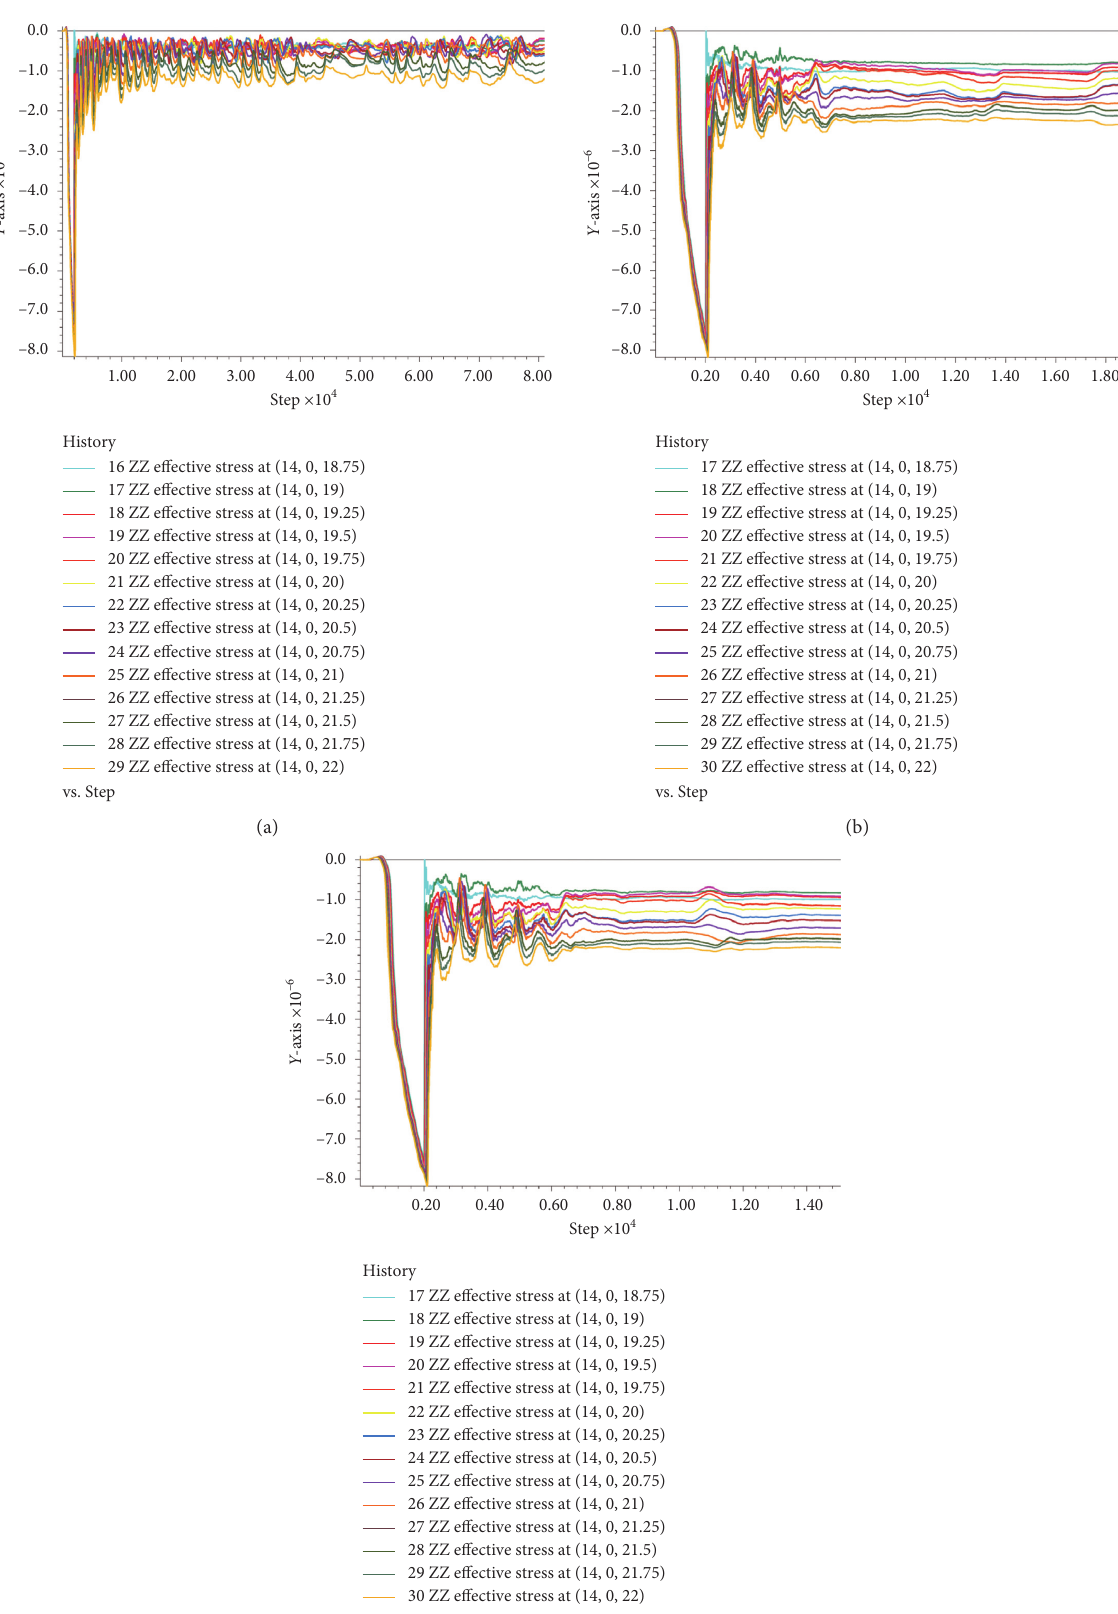
Figure 8: Variation of maximum effective stress of roadway roof. (a) No support state. (b) Supporting state of non-truss anchor cable. (c) Support state of truss anchor